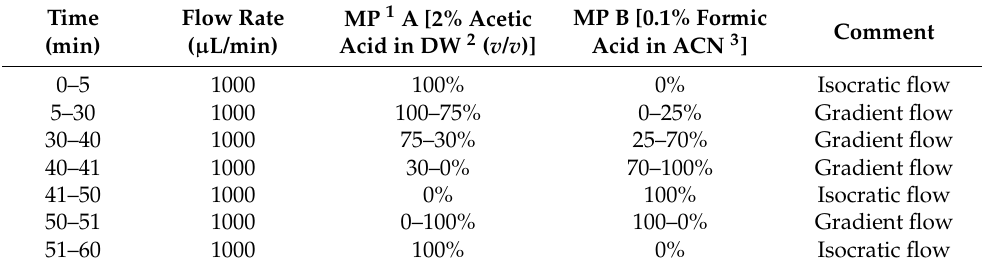
Table 2. Running conditions of mobile